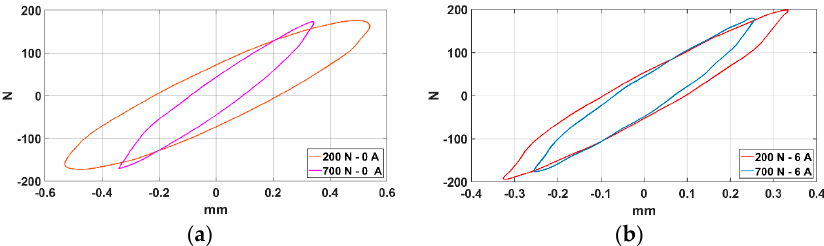
Figure 17. Sample tests for a forcing frequency of 2 Hz with a maximum horizontal force of 200 N: ( a ) current intensity of 0 A, shear stiffness: 330 N/mm at 200 N and 500 N/mm at 700 N; ( b ) current intensity of 6 A, shear stiffness: 600 N/mm at 200 N and 700 N/mm at 700 N. 6. MRE Dynamic Model To analyze the dynamic behavior of the MRE element, we propose a theoretical model [20], whose scheme is reported in Figure 18.